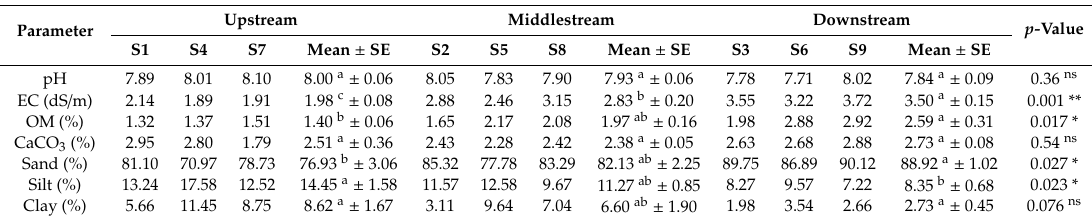
Table 1. Physicochemical characteristics of sediment samples collected from di ff erent sites (S1–S9) representing three sectors of drains moving toward Burullus